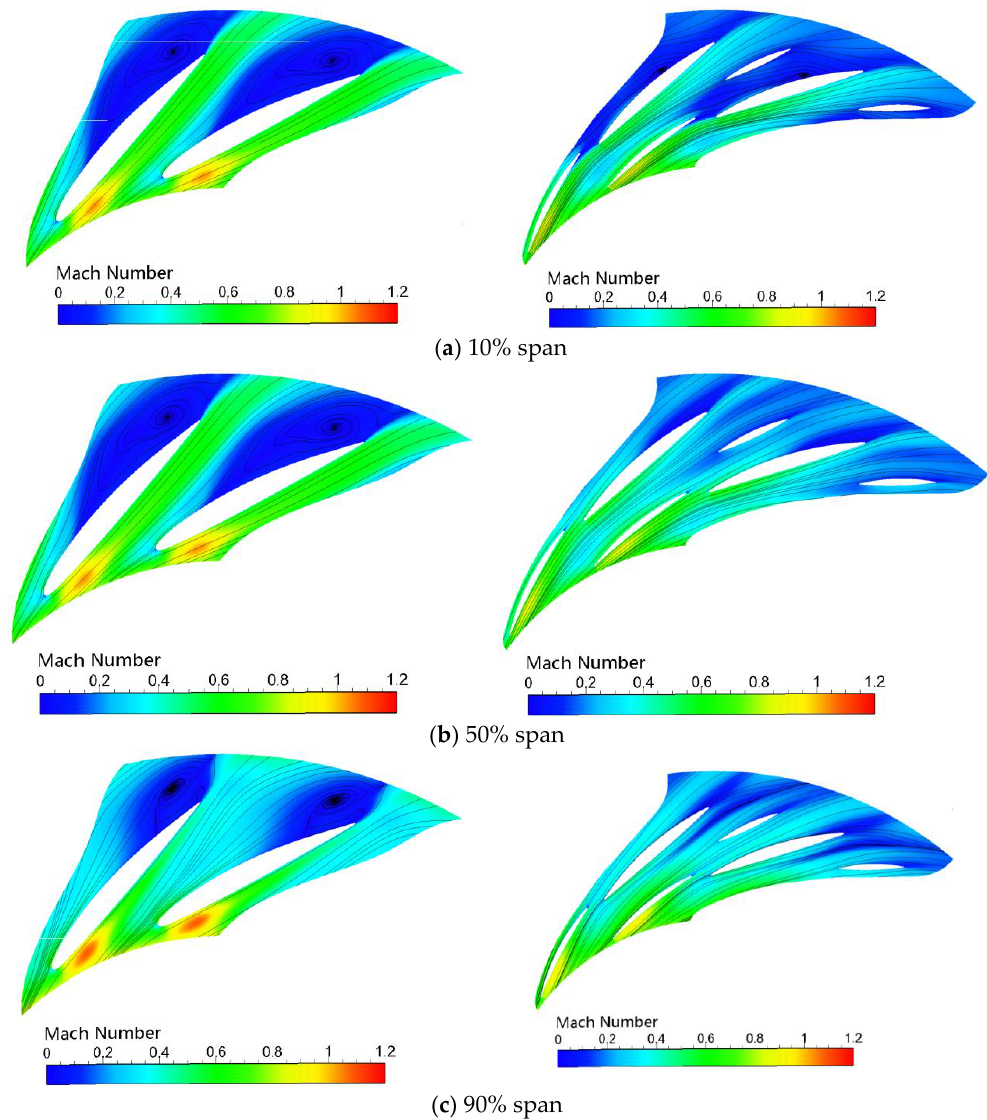
Figure 16. Mach number distribution at different spans of the original and optimized designs of the high-pressure-stage centrifugal compressor at 100% load.